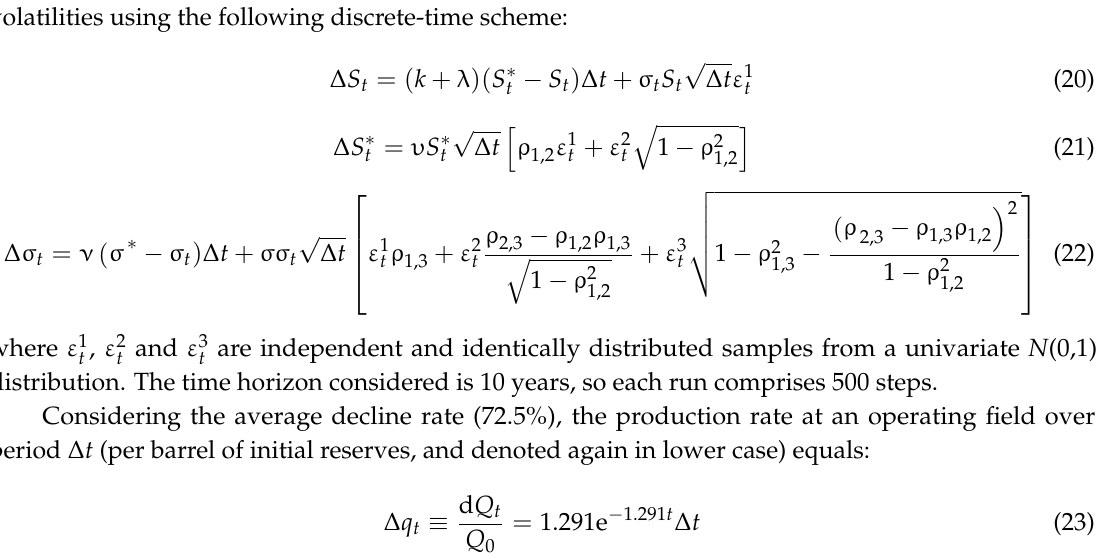
Table 3. Present value (PV) of cumulative 10-year revenue per barrel of initial reserves, i ( S 0 , S ∗